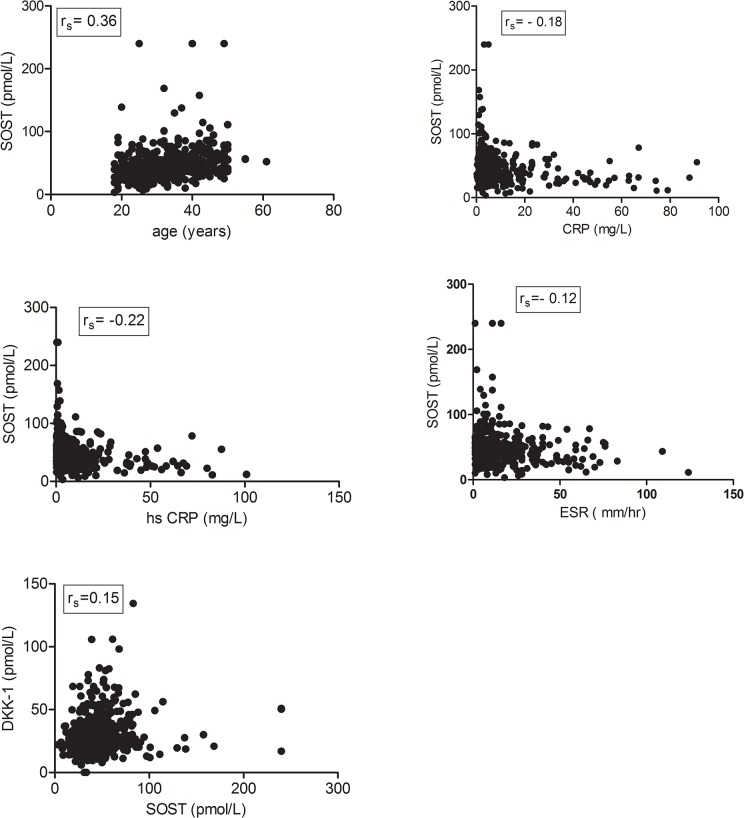
Correlation of SOST serum level with age.(A) (rs = 0.36; p<0.0001), C-reactive protein (CRP) level (B) (rs = -0.18; p = 0.0001), high-sensitivity CRP (hs-CRP) level (C) (rs = -0.22; p<0.0001), erythrocyte sedimentation rate (ESR) (D) (rs = -0.12, p = 0.007) and Dickkopf-1 (DKK-1) serum levels (E) (rs = 0.15, p = 0.0008); rs: Spearman correlation coefficient.